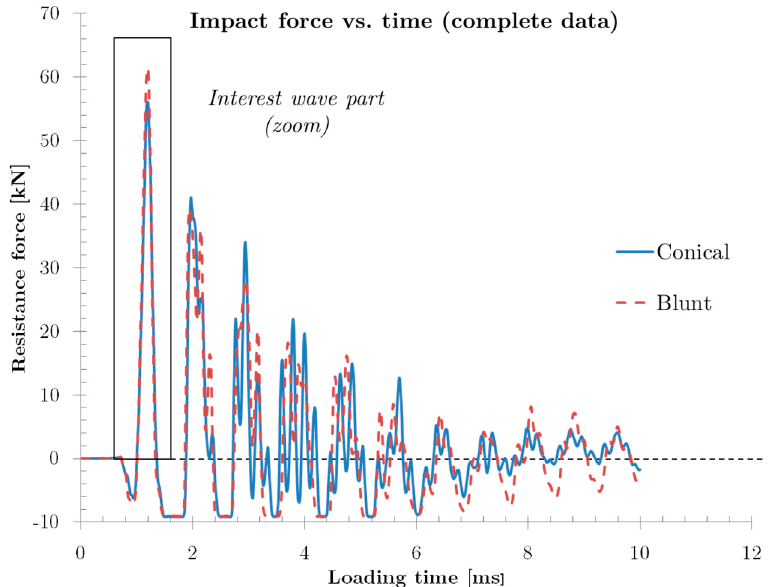
Figure 7. Resistance force history recorded using piezoelectric sensors for blunt and conical projectile (impact velocity v = 174 m/s).